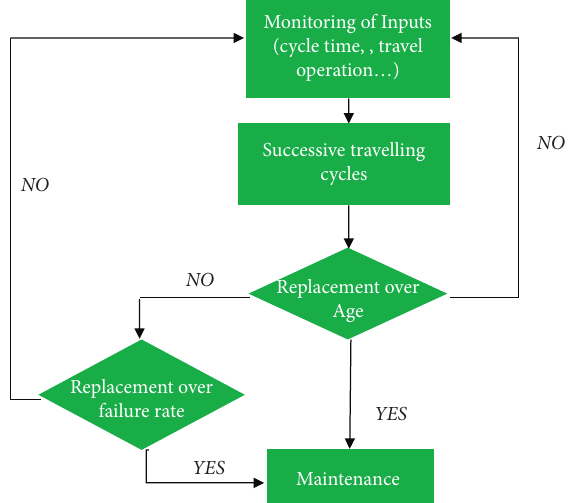
Figure 1: The flow sheet for the maintenance of seaport container